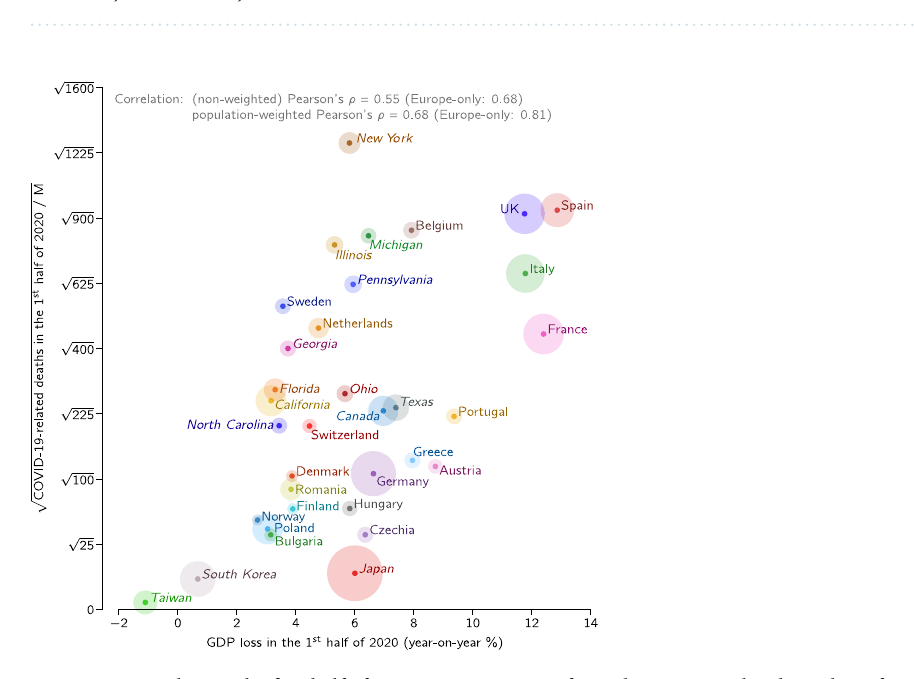
Figure 5. GDP loss in the first half of 2020 vs. square root of population-normalized number of epidemic- associated deaths in the same period for European and East Asian countries, ten US states, and Canada. Disk area of each location is proportional to its